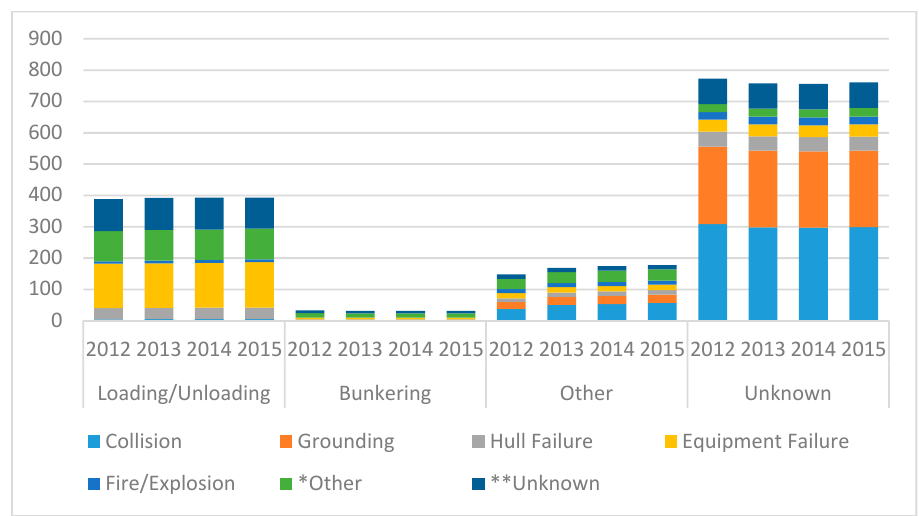
Table 6. Statistics on oil spills of 7–700 tons from 2012 to 2015.